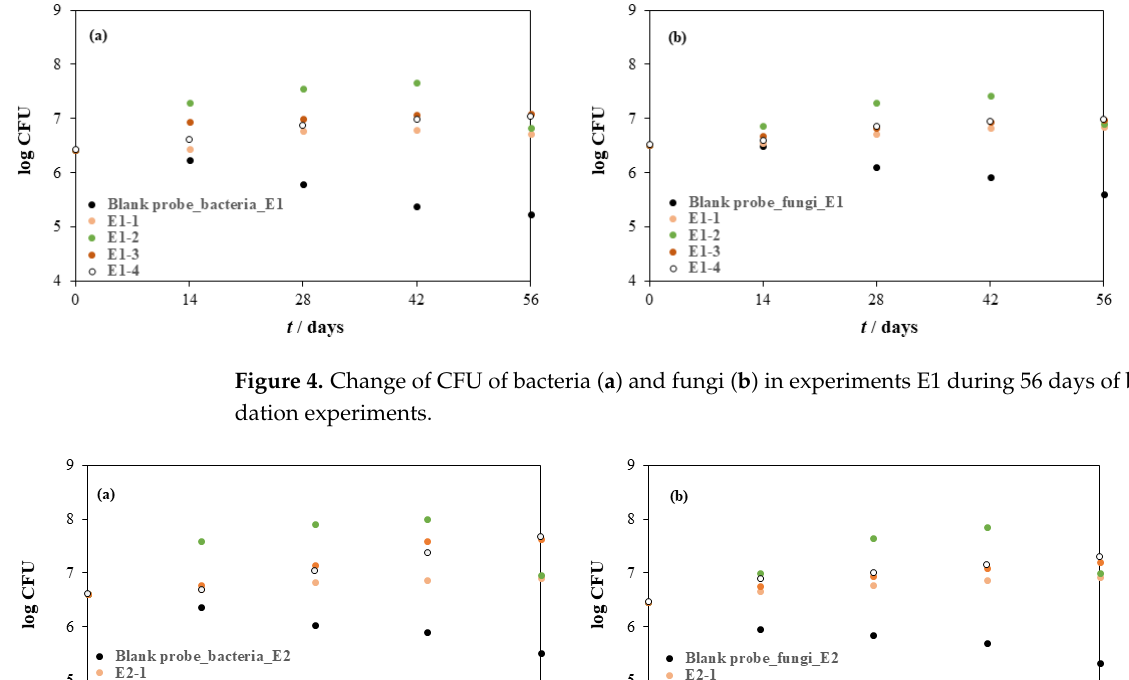
Figure 6. Change of dissolved oxygen concentration in experiments ( a ) E1 and ( b ) E2 during 56 days of biodegradation experiments. Table 5. Weight loss of polymer materials after screening test. Experiment